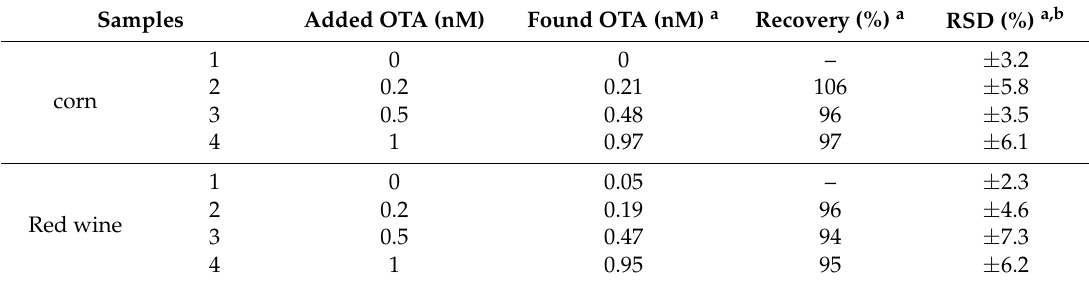
Table 2. Determination of OTA in corn and red wine samples with the proposed